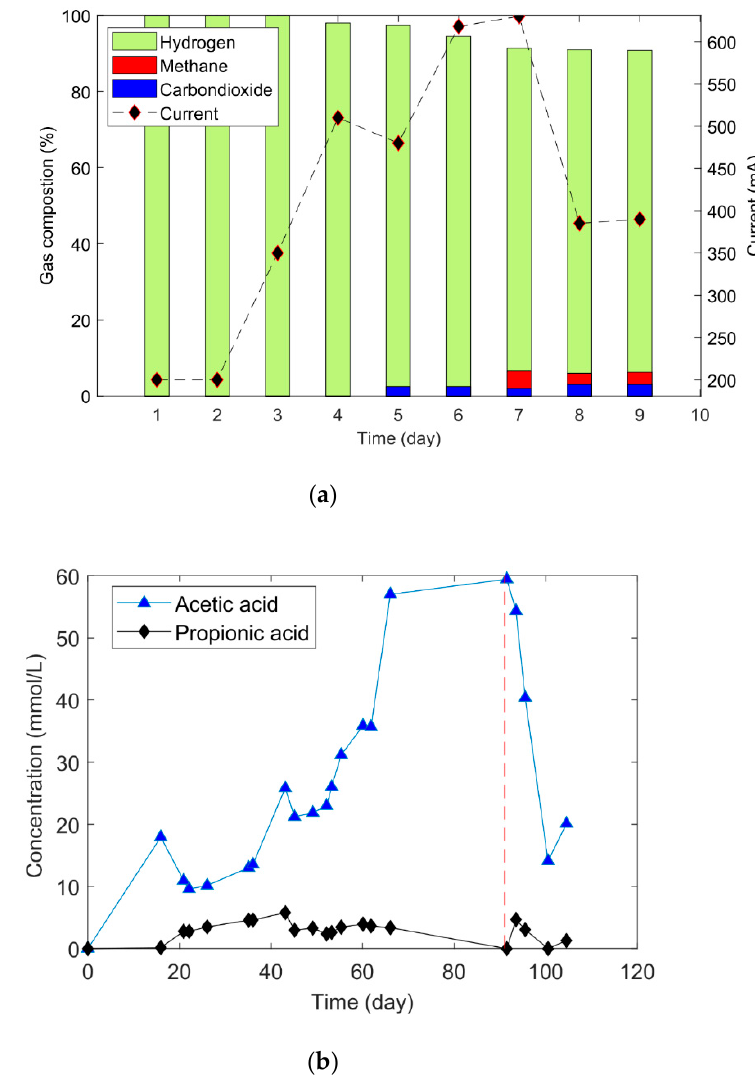
Figure 3. ( a ) The gas composition and the current variation during Phase 3. ( b ) The fermentation- product formation throughout Phases 2 and 3 (separated by a red vertical line).